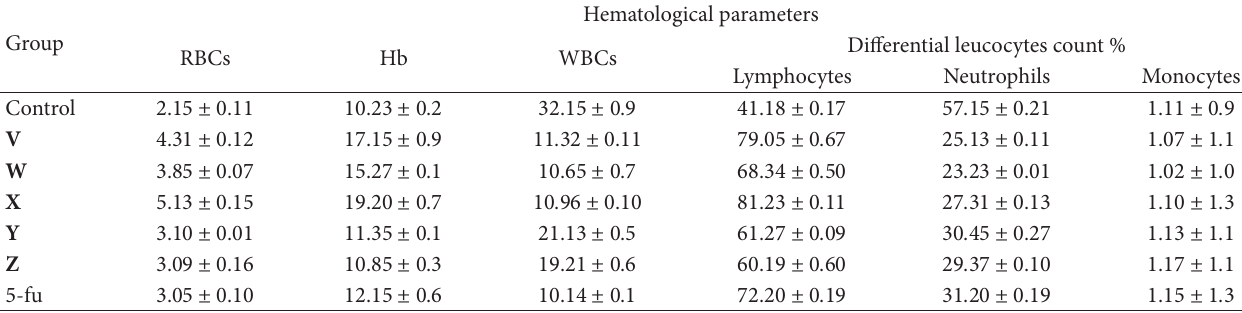
T 2: Effect of the Ag (I) complexes on hematological parameters.